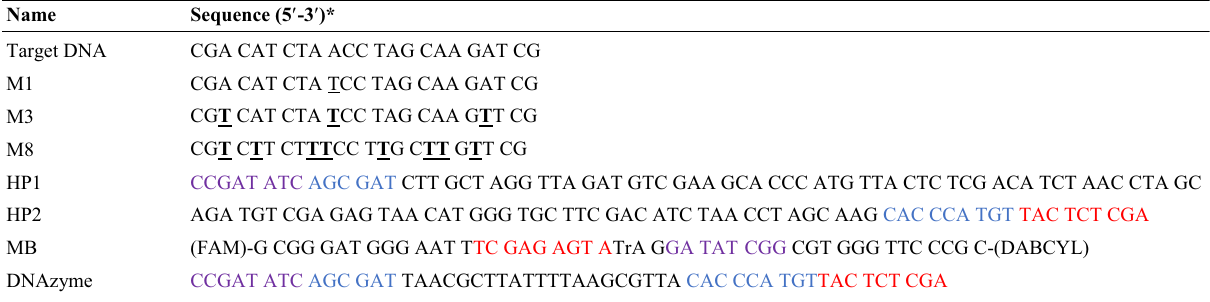
Table 2: Oligonucleotides used in the experiments Name Target